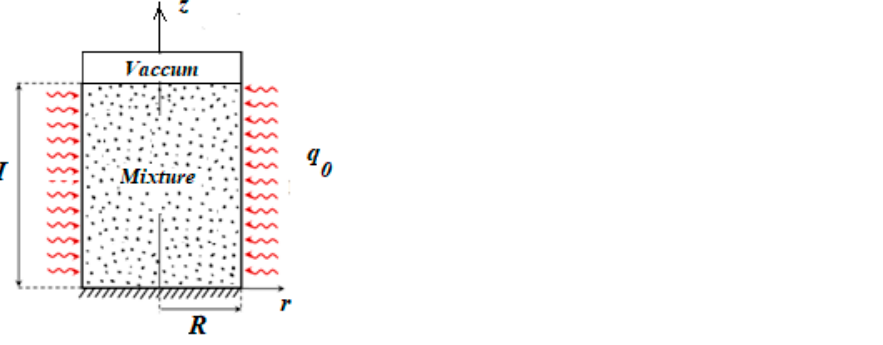
Figure 2. Physical model of the hydrothermal carbonization (HTC) batch reactor.